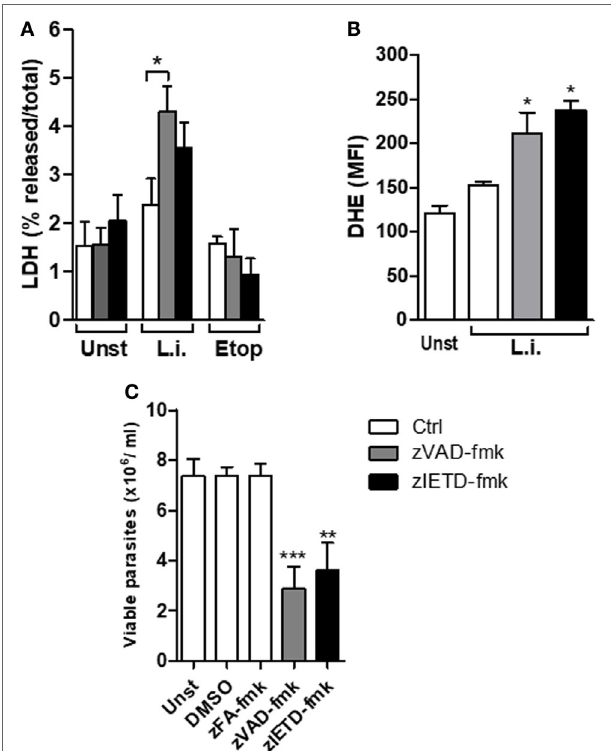
FigUre 4 | zVAD-fmk and zIETD-fmk treatment induces cell damage, high ROS production, and reduces Leishmania infantum parasite viability in murine neutrophils. Inflammatory neutrophils from C57BL/6 mice were obtained after i.p. thioglicolate (3%) injection. Neutrophils (5 × 10 5 /well) were pretreated